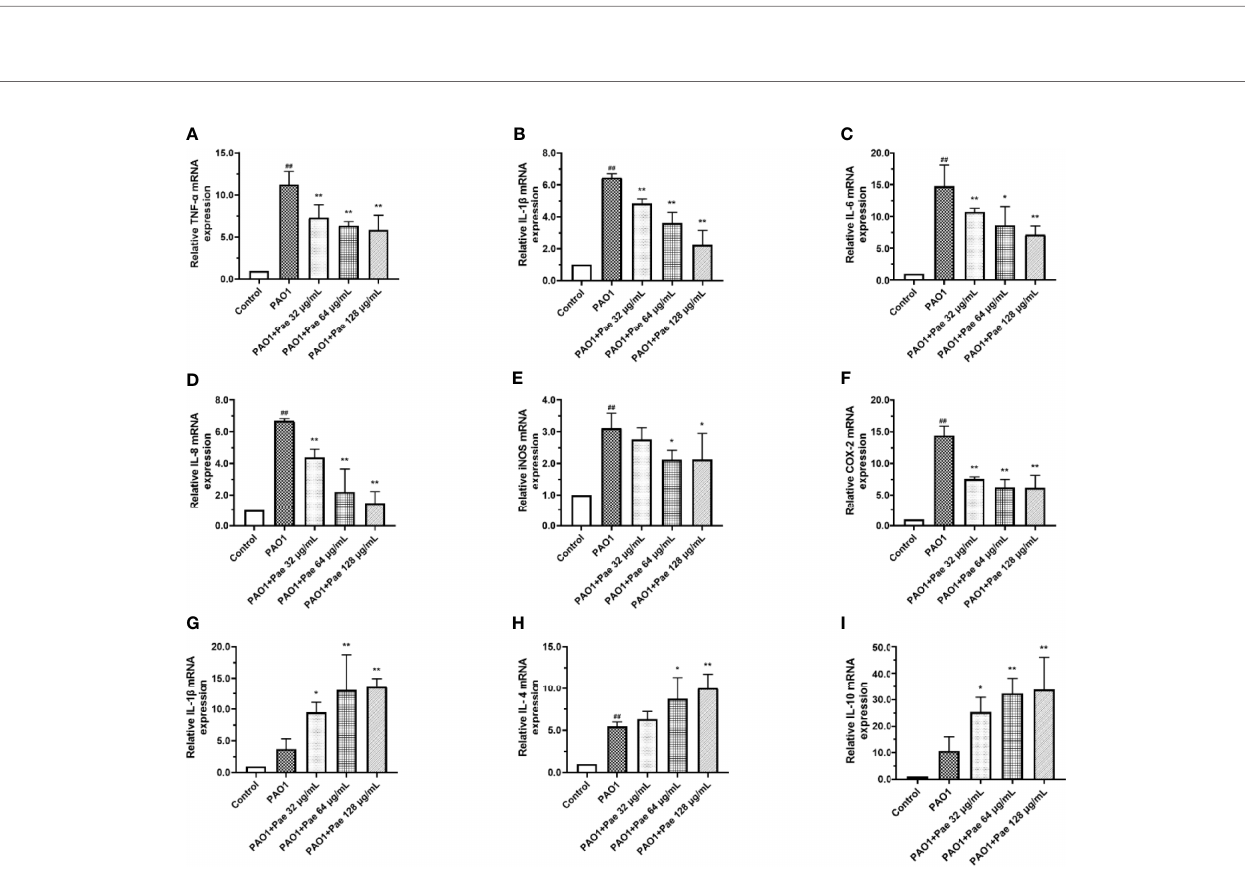
FIGURE 8 | Cytokines mRNA expression were tested in PAO1-infected RAW264.7 (MOI = 100:1) with paeonol treatment. (A) TNF- a , (B) IL-1 b , (C) IL-6, (D) IL-8, (E) iNOS, (F) COX-2, (G) IL-2, (H) IL-4, (I) IL-10, “ PAO1+Pae 32 m g/mL ” , “ PAO1+Pae 64 m g/mL ” , “ PAO1+Pae 128 m g/mL ” indicate that RAW264.7 cells were infected with PAO1 and treated with paeonol. The expression of mRNA was tested by RT-PCR. All data were expressed as means ± SD (n=3). # p < 0.05, ## p < 0.01 vs. control Group, * P < 0.05 or ** P < 0.01 vs the PAO1 group.